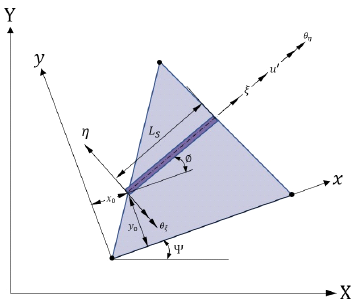
Figure 4. Local coordinate system of a stiffener within a flat shell element.